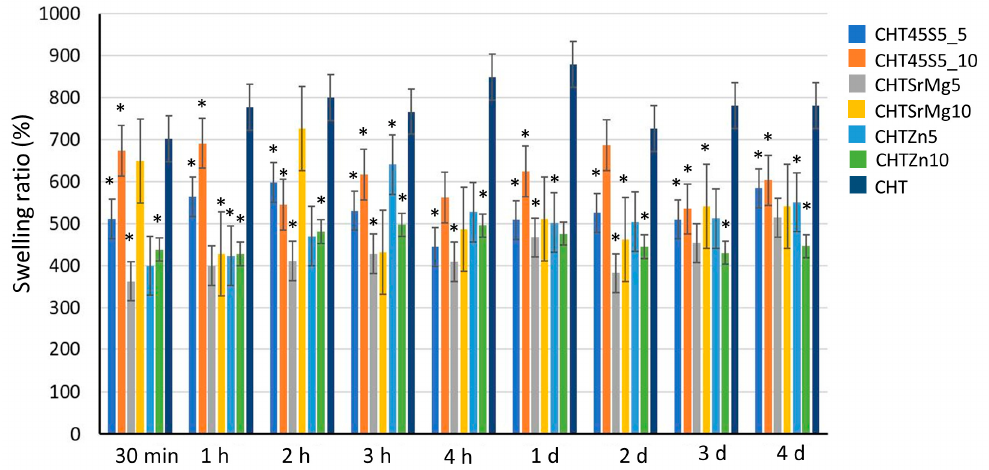
Figure 3. Swelling ratio of wound dressings: 30 min, 1 h, 2 h, 3 h, 4 h, 1 day, 2 days, 3 days, and 4 days after immersion in distilled water. * p < 0.05.